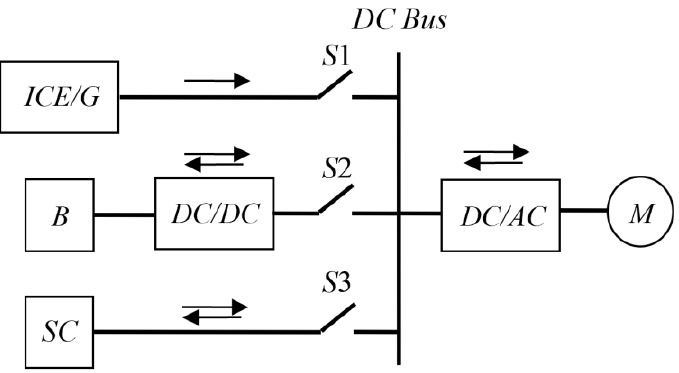
Figure 3. Combined vehicle system with ICE/G as main power source.